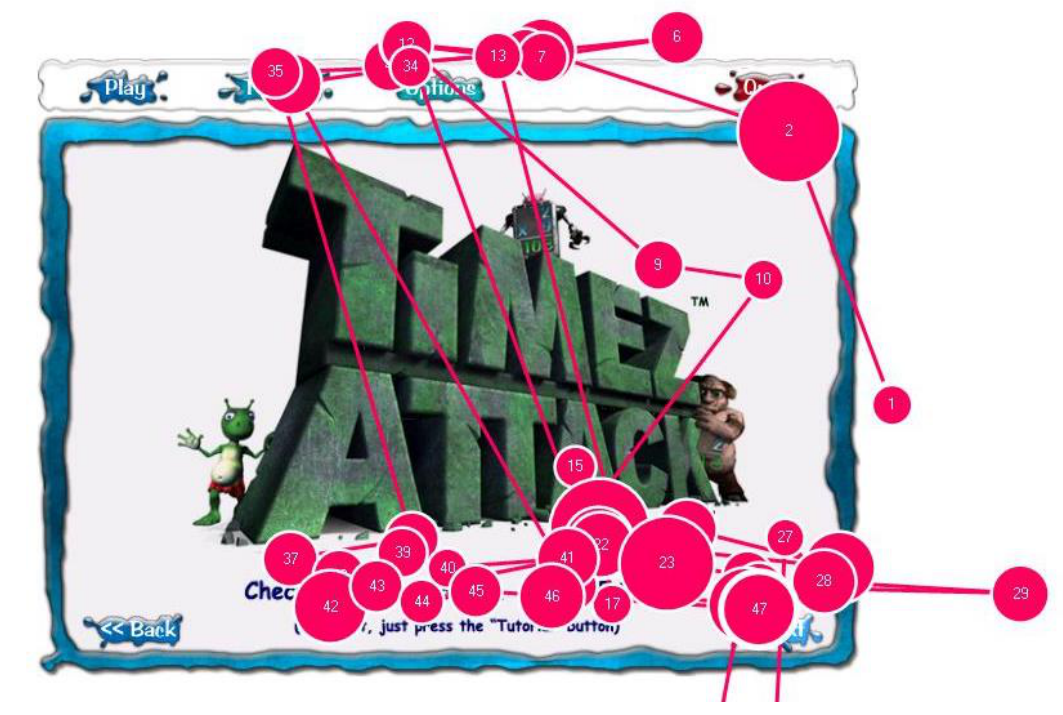
Figure 3 Fixations of an adult novice on the opening